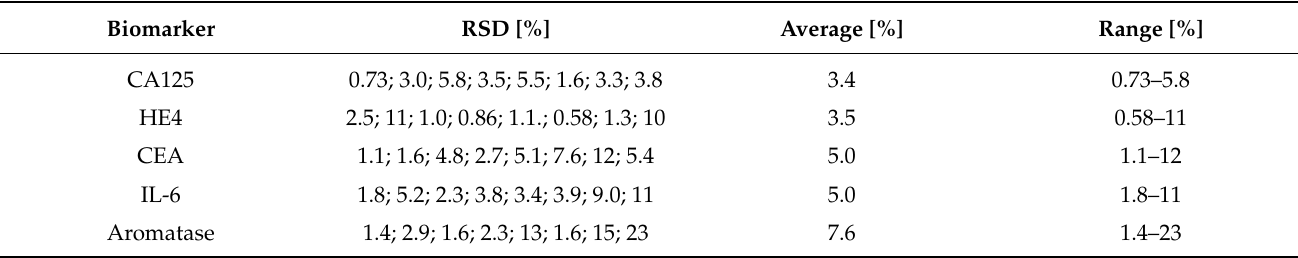
Table 2. Precision of measurements of biomarker concentration in eight real